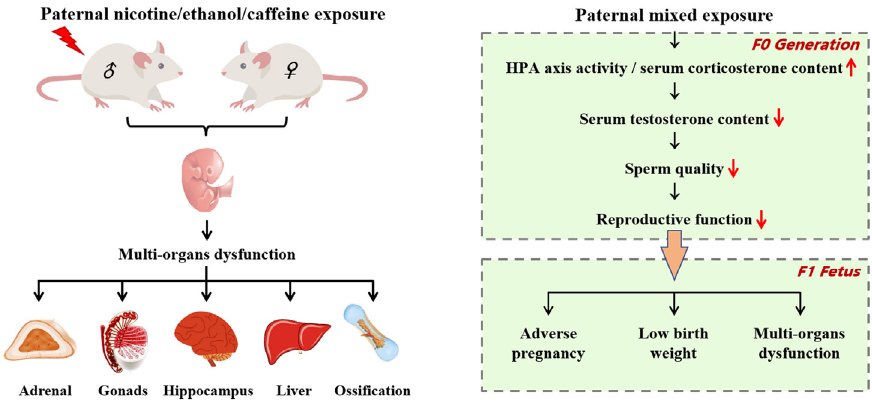
Figure 8. Paternal nicotine/ethanol/caffeine mixed exposure induces adverse pregnancy outcomes and offspring multi-organ dysfunction. ↑ : elevate; ↓ : decrease.